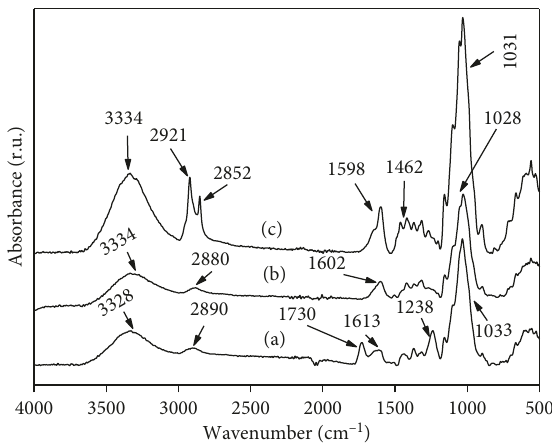
Figure 1: FT-IR spectra of (a) raw POF, (b) NaOH-treated POF, and (c) CTAB-modified